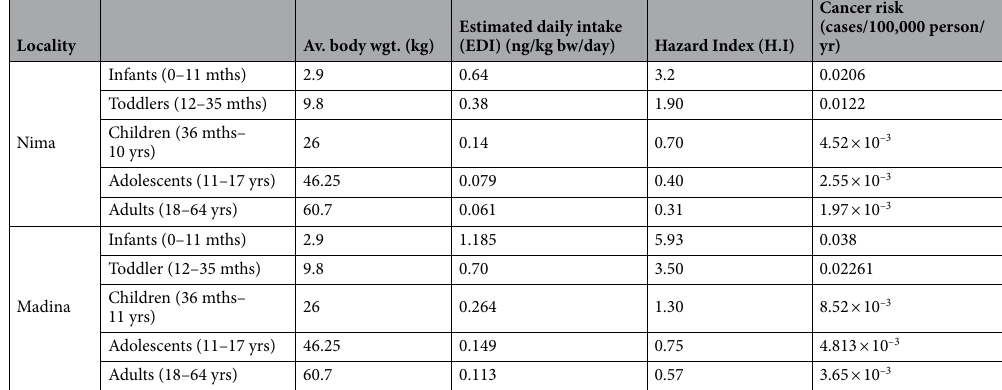
Table 4. Risk evaluation for AFM 1 via consumption of brukina samples obtained from Greater Accra region of Ghana. Mean of AFM 1 —Nima = 0.27 µg/kg, Madina = 0.5017 µg/kg. Daily intake of milk for infants was halved (0.5 × 0.0137 kg). Average body weights were obtained from the different ranges referenced by the authors. Average potency for AFM 1 = 0.0323. 1 µg = 1000 ng. H.I Hazard Index.